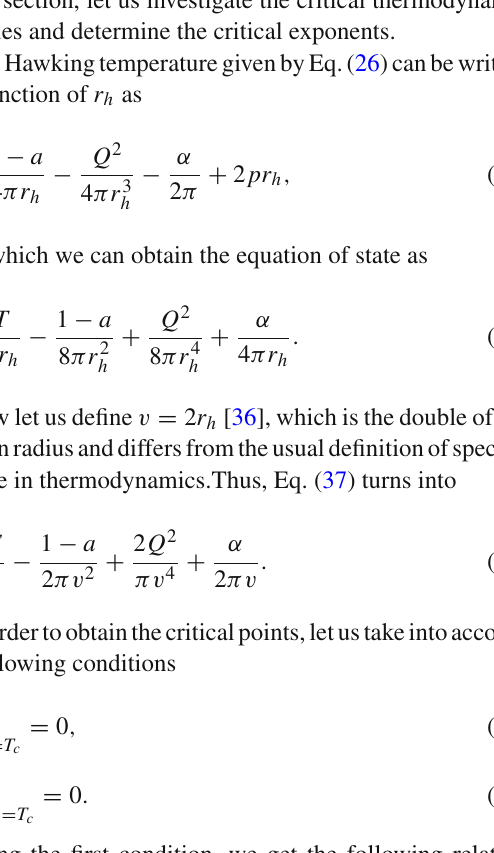
Fig. 6 Graphs p x V for T = 0 . 1, α = 0 . 01 and different values of a